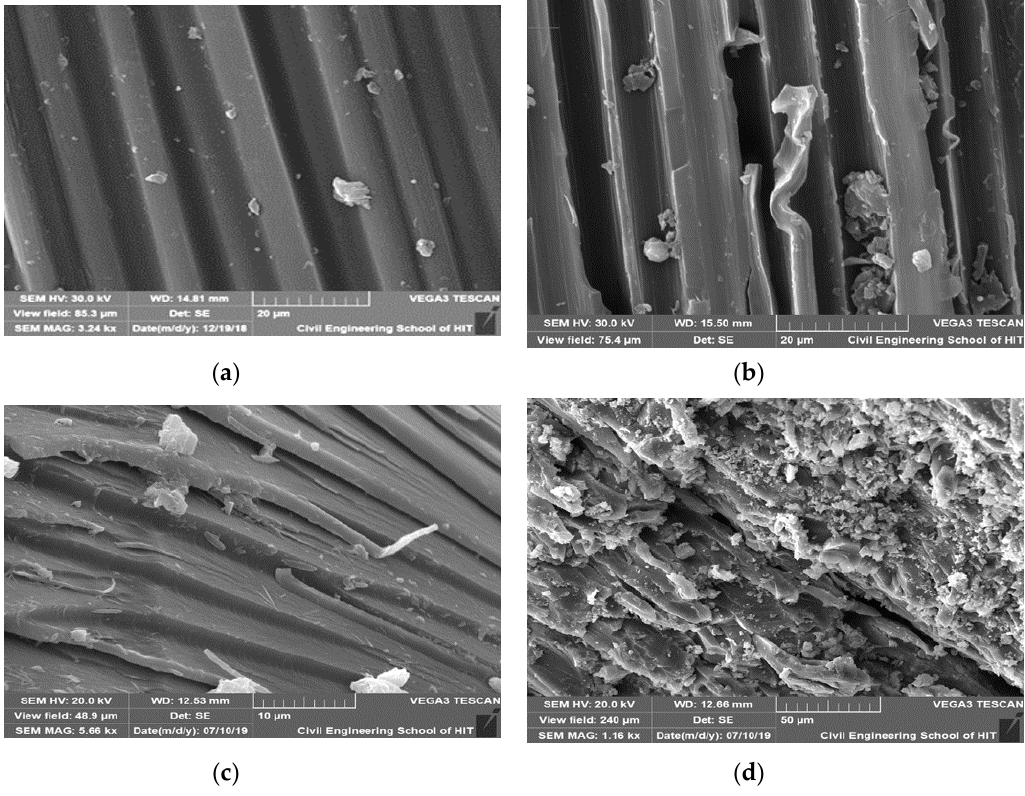
Figure 11. SEM images of the specimens ( a ) unaged CFRP composite, tensile fractured surface of ( b ) aged CFRP composites in HCl solution at 60 °C for 80 days, ( c ) unaged epoxy resin and ( d ) aged epoxy resin in HCl solution at 60 °C for 80 days.